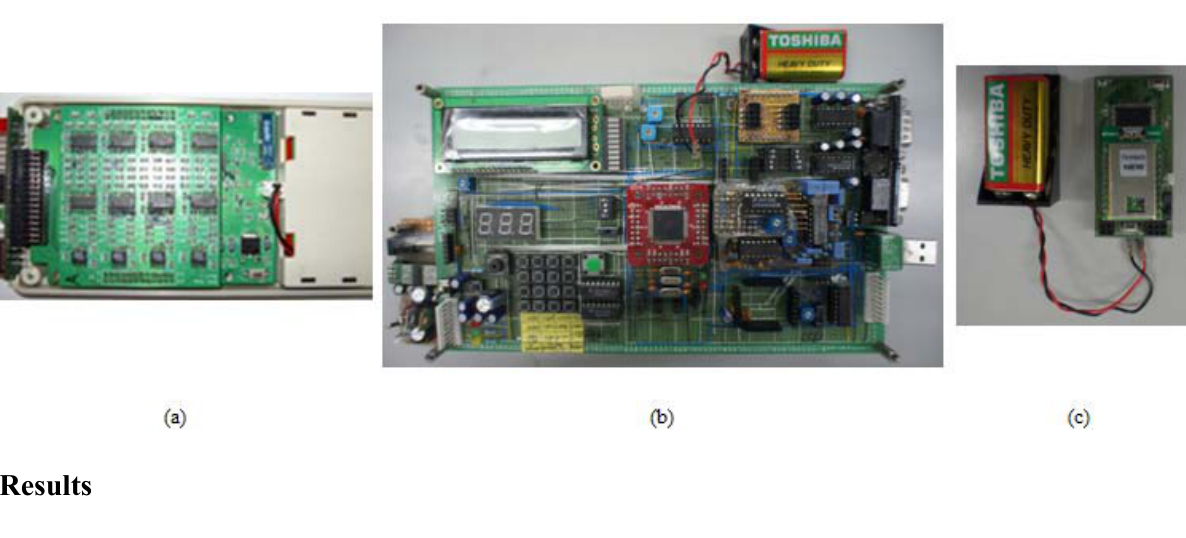
Figure 8. View of three type sensor platform for power consumption checking: ( a ) 8 channels EEG sensor platform using Zigbee communication; ( b ) Previous four channel multi-body sensor platform using Bluetooth communication; ( c ) Enhanced four channel multi-body sensor platform using Bluetooth